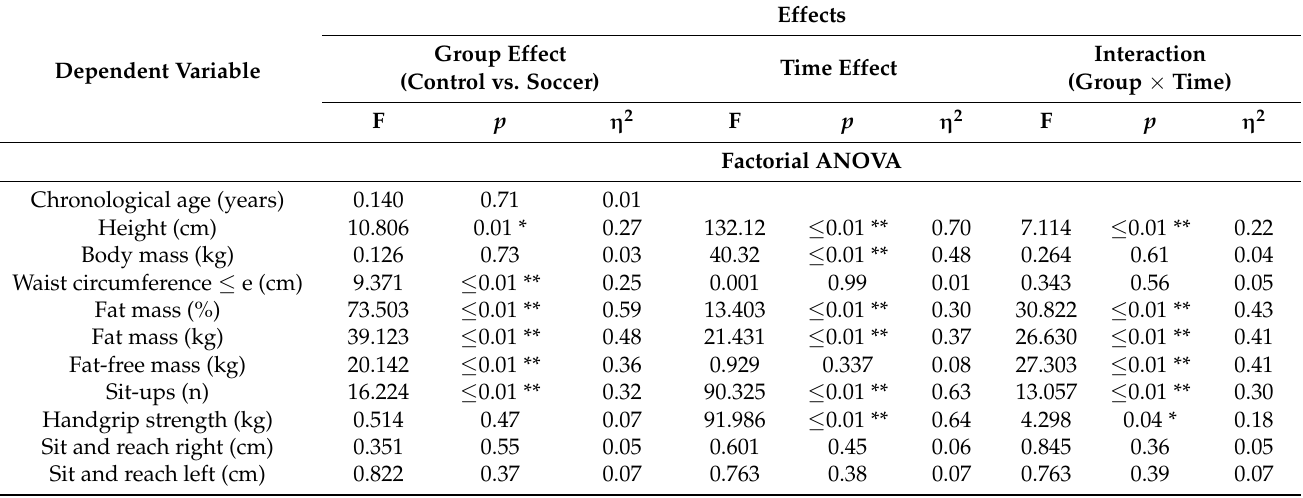
Table 2. Results of repeated measures ANOVA to examine the effects of sports participation, 12-month follow-up, and interaction among male adolescents (controls, n = 75; soccer players, n =